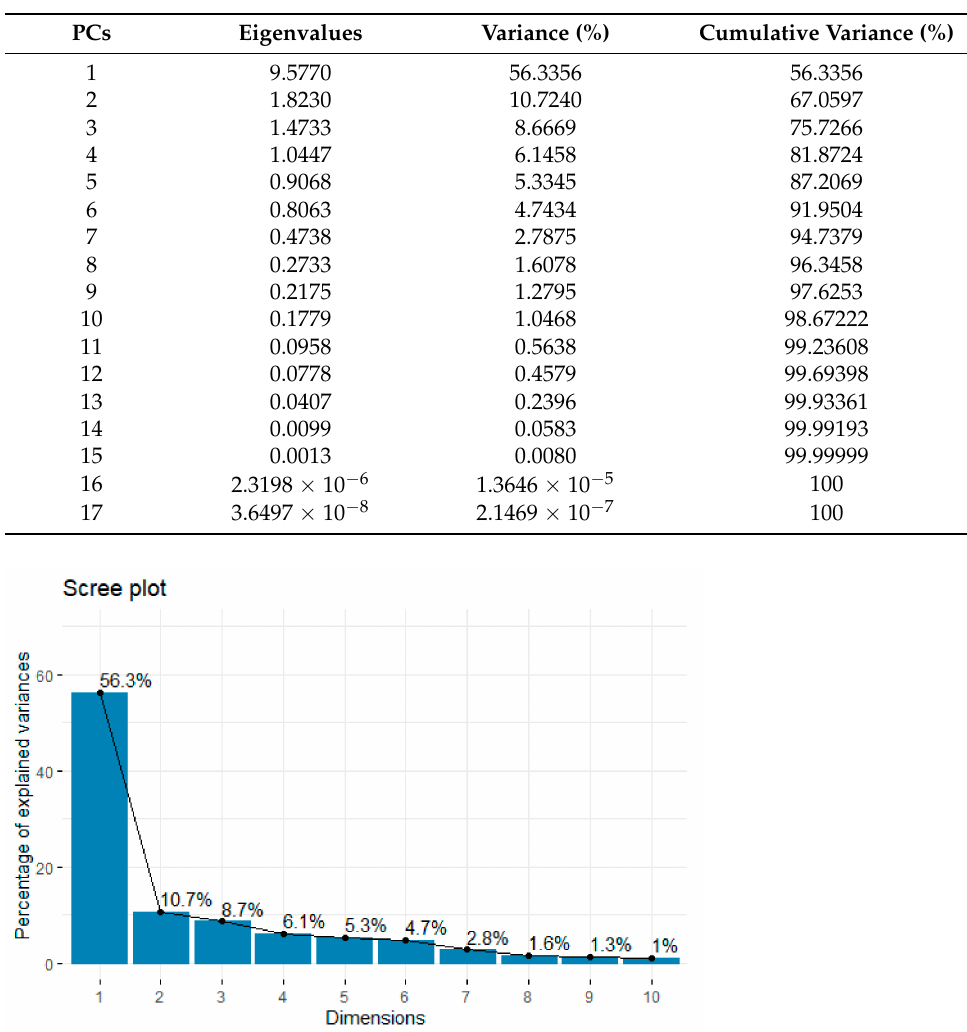
Table 4. Principal components (PCs).